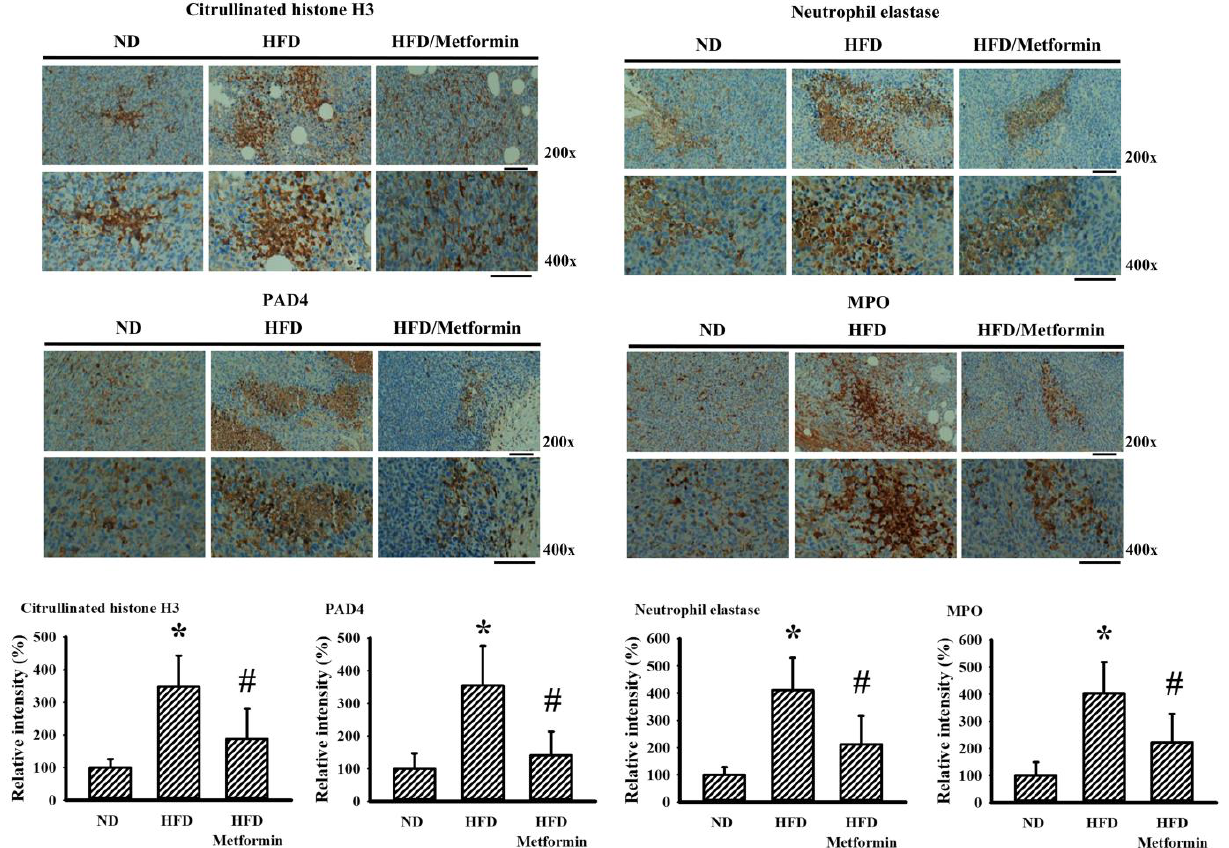
Figure 8. Metformin mitigated tissue parameters of NETs in obese mice. ND-fed lean and HFD-fed obese mice were subcutaneously inoculated with LLC cells over a course of three weeks. Three days after cell implantation, ND-fed lean mice were daily treated with saline vehicle through intraperitoneal injection (ND). HFD-fed obese mice were separated into two groups receiving daily intraperitoneal injections of a saline vehicle (HFD) or metformin (50 mg/kg, HFD/Metformin) for the final 18 days. Immunohistochemical examination was performed in paraffin-embedded tumor tissues with indicated antibodies. Representative photomicrograph and quantitative data are shown, as described in methodology. * p < 0.05 vs. ND and # p < 0.05 vs. HFD, n = 6. Scale bar: 50 μ m.